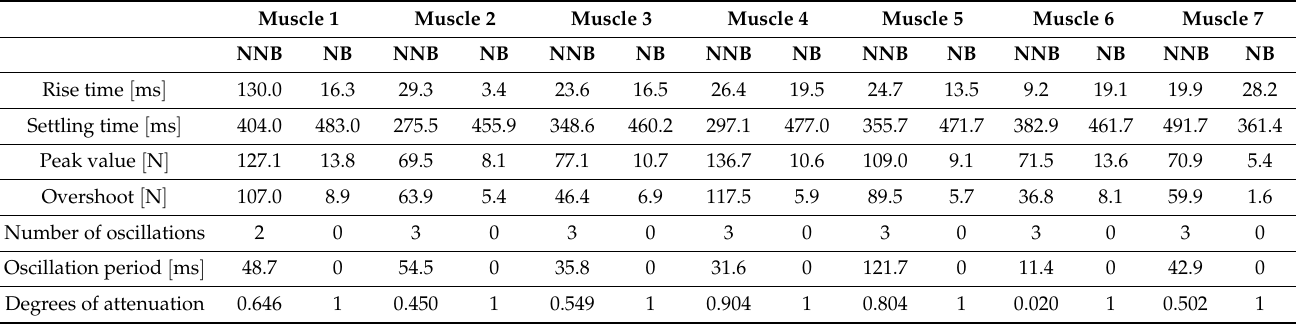
Table 8. Selected metrics for evaluating the performance of arm reaching movements under